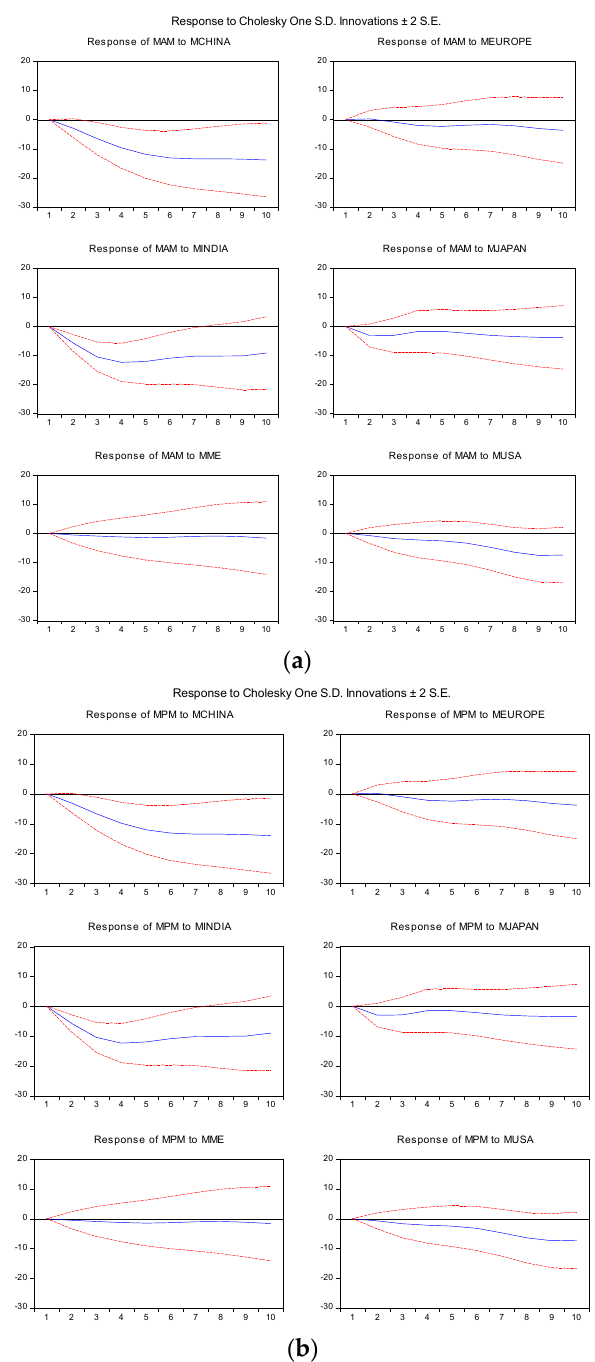
Figure 2. Transmission of shocks of price on AM Fix ( a ) and PM Fix prices ( b ).